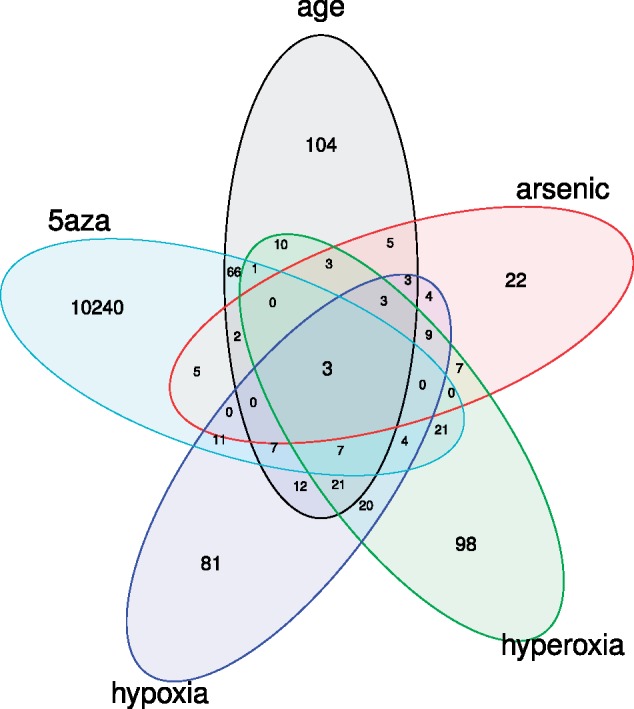
—Venn diagram of differentially methylated CpGs (DMCs) in D. magna Bham2. The Daphnia were exposed to different stress conditions (arsenic, hypoxia, hyperoxia, 5ʹ-azacitidine) and normal ageing process (5 vs. 14 day old Daphnia), showing a relatively small amount of overlap in the DMCs among the conditions.